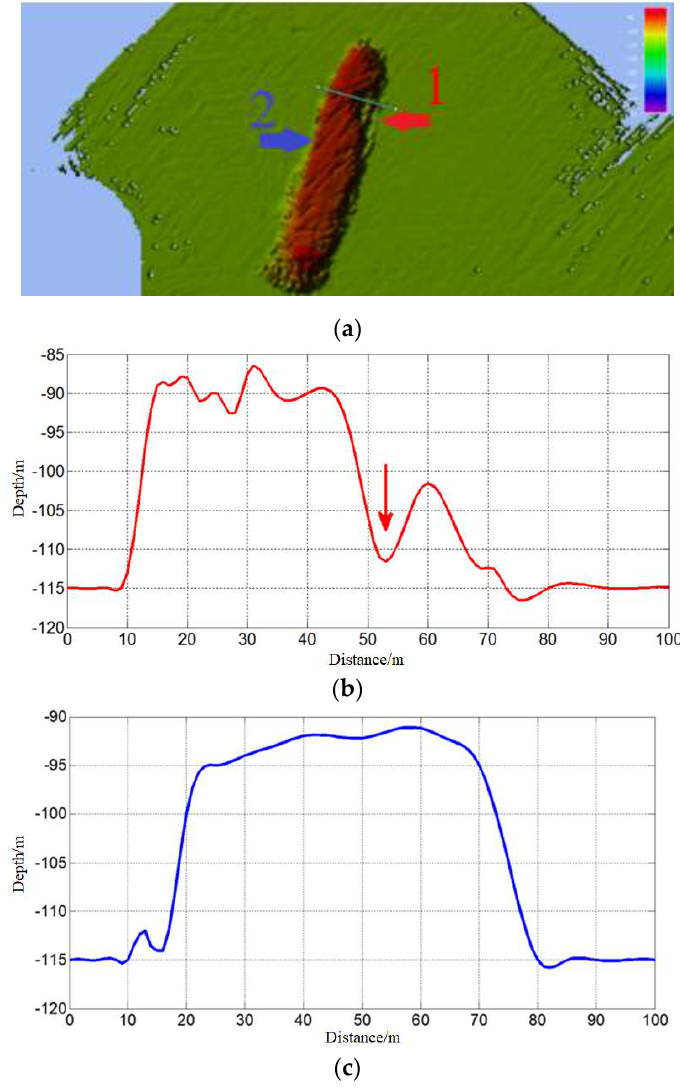
Figure 19. Cross-sectional view of ‘Sanchi’ multibeam: ( a ) Cross-section position, ( b ) height change of cross-sections 1, ( c ) height change of cross-sections 2.